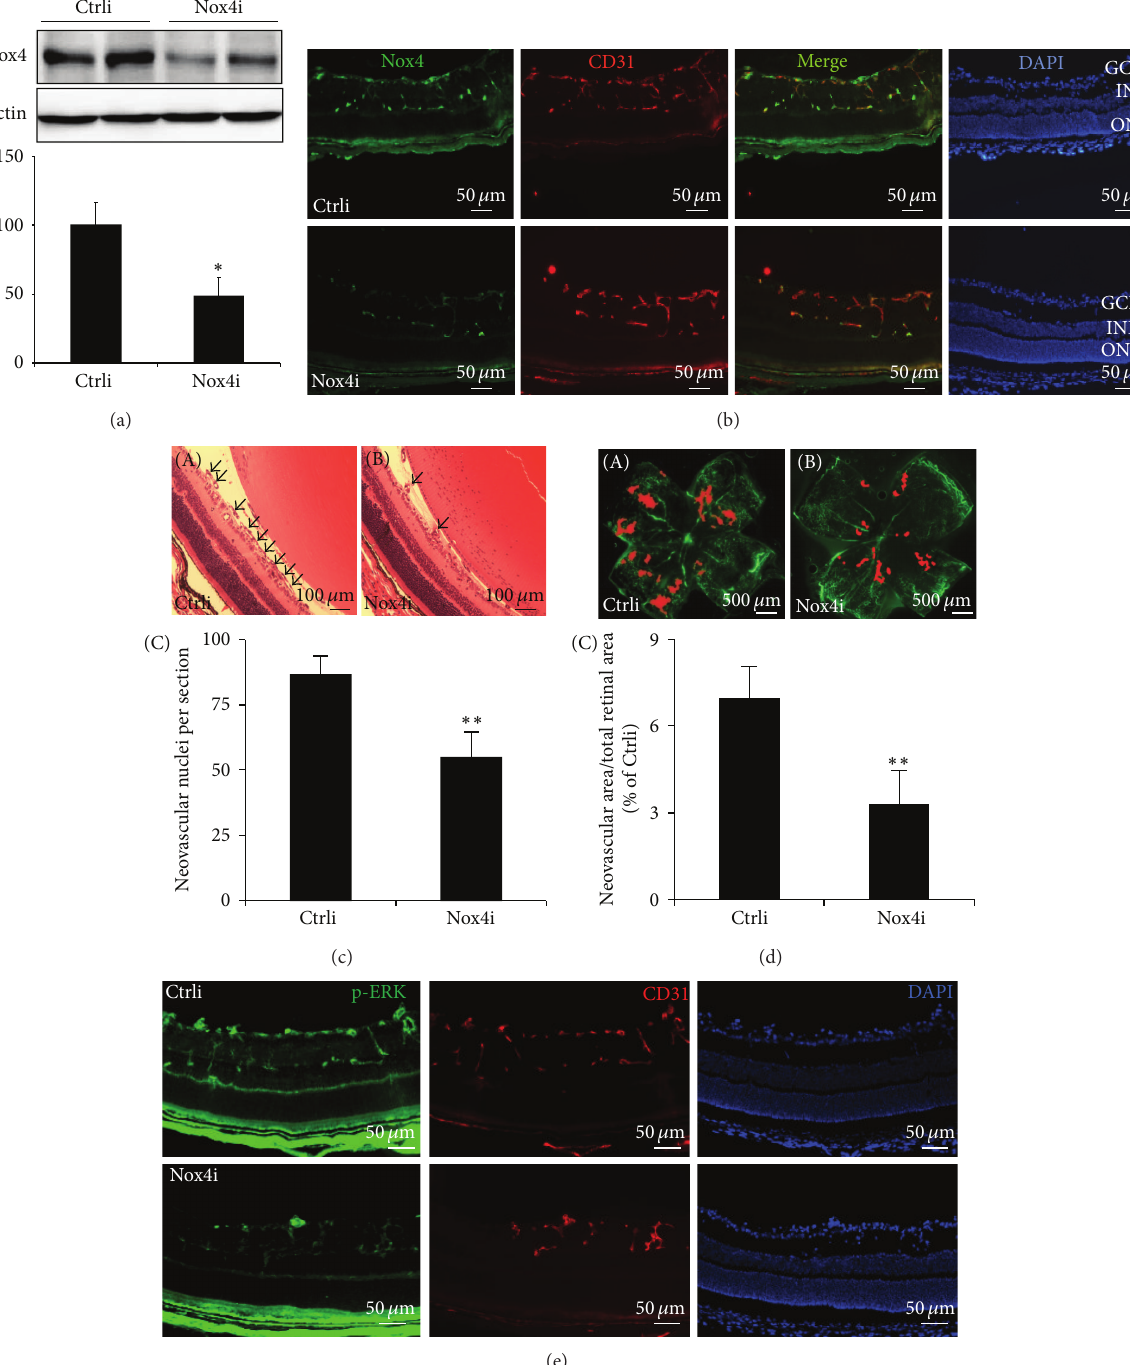
Figure 6: Knockdown of Nox4 ameliorates retinal NV in OIR mice. Ad-Ctrli and Ad-Nox4i were periocularly delivered to OIR mice at P12. (a-b) Retinal expression of Nox4 was determined by Western blot analysis at P15 (a) and immunostaining (b) at P17. 𝑛 = 3 for each group; ∗ 𝑃 < 0.05 versus Ctrli. (b) Upper panel: Ad-Ctrli injected group and lower panel: Ad-Nox4i injected group. (c-d) Retinal NV formation was evaluated at P17 by counting nuclei of pre-ILM vasculature after HE staining (c) and by retinal angiography (d). HE staining: (c-A) retina from Ad-Ctrli injected mouse, (c-B) retina from Ad-Nox4i injected mouse, and (c-C) quantification result from 6 different mice in each group. Retinal angiography (d-A) retina from Ad-Ctrli injected mouse, (d-B) retina from Ad-Nox4i injected mouse, and (d-C) quantification result from 5 different mice in each group. ∗ 𝑃 < 0.05 or ∗∗ 𝑃 < 0.01 versus Ctrli. (e) Phosphorylation of ERK (green) and its colocalization with endothelial marker CD31 (red) were evaluated by immunostaining in P17 retinas. Images were representative of 4 different